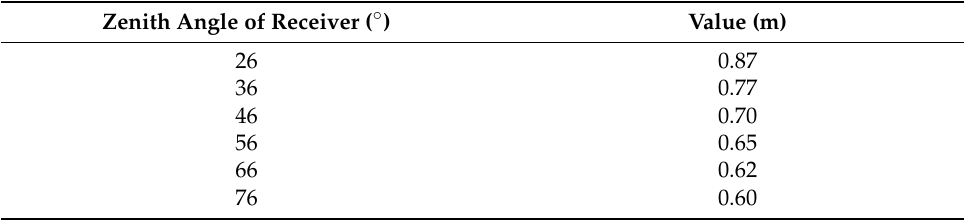
Table 4. Range resolution of different receiving